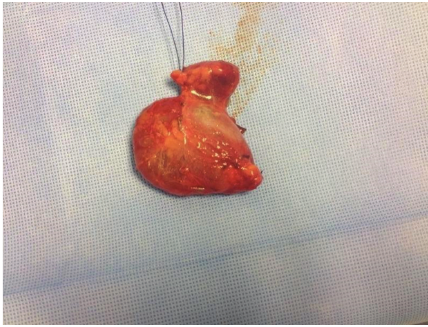
Figure 7: Intraoperative picture showing the cyst after removal with leaking clear fluid